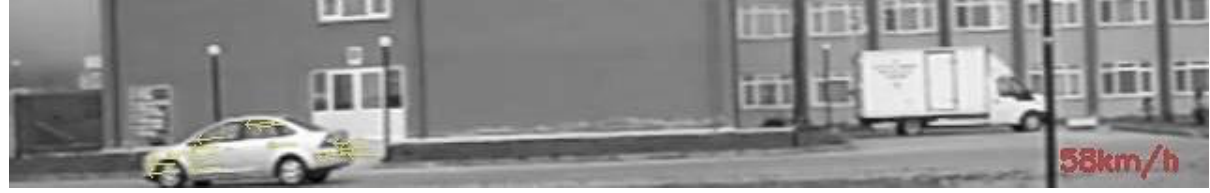
Figure 3. Error free vectors and